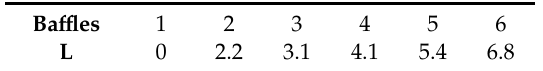
Table 2. Cross-sections and locations for flow